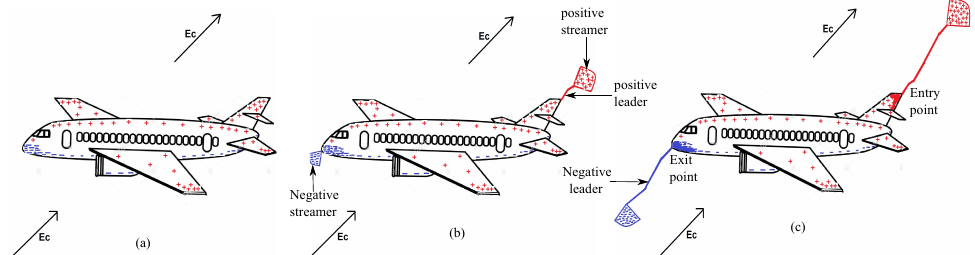
Figure 1. Schematic showing inception and propagation of connecting leaders from a flying aircraft ( a ) Distribution of the induced charges on the aircraft surface under the influence of negative am- bient field (upward directed), ( b ) Inception of positive leader discharge from the vertical